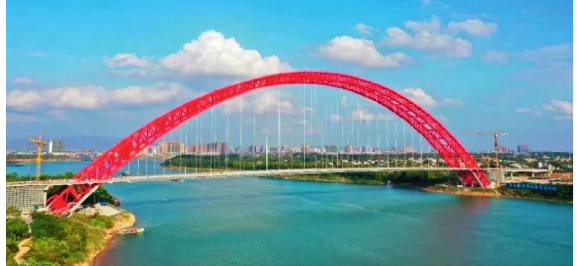
Figure 2: Third Pingnan